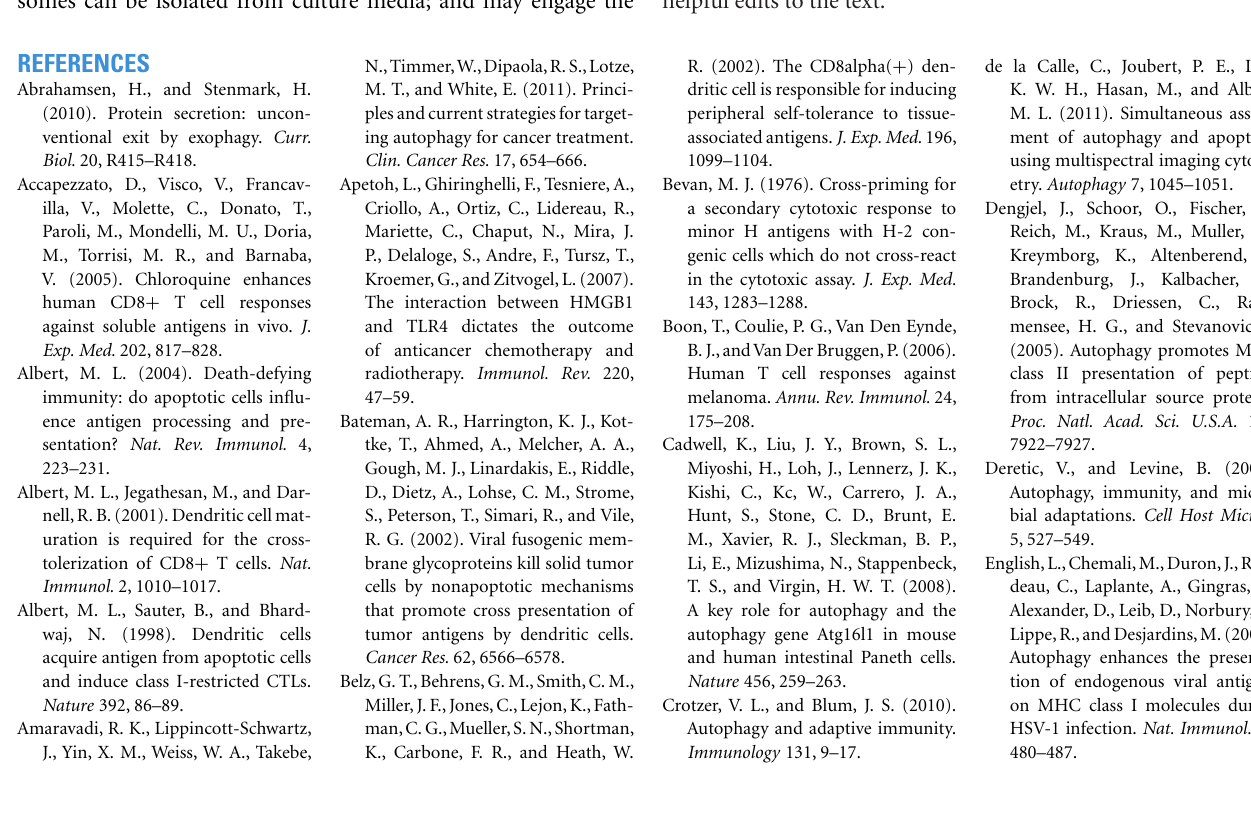
( Figure2 ).Oncewithinthephagosome,autophagiccellsmayserve as stimulators of PRRs, further enhancing the phagocyte’s cross- priming potential. Another interesting line of investigation will be the autophagosome itself, which may serve to protect antigen from degradation and facilitate delivery APCs. A detailed evalu- ation of how autophagy favors cross-priming may help launch new immunotherapy strategies for treating cancer or chronic disease. Moreover, it may provide a mechanistic understand- ing of currently used chemotherapies (e.g., cyclophosphamide or methotrexate) or experimental compounds (e.g., rapamycin given in combination with